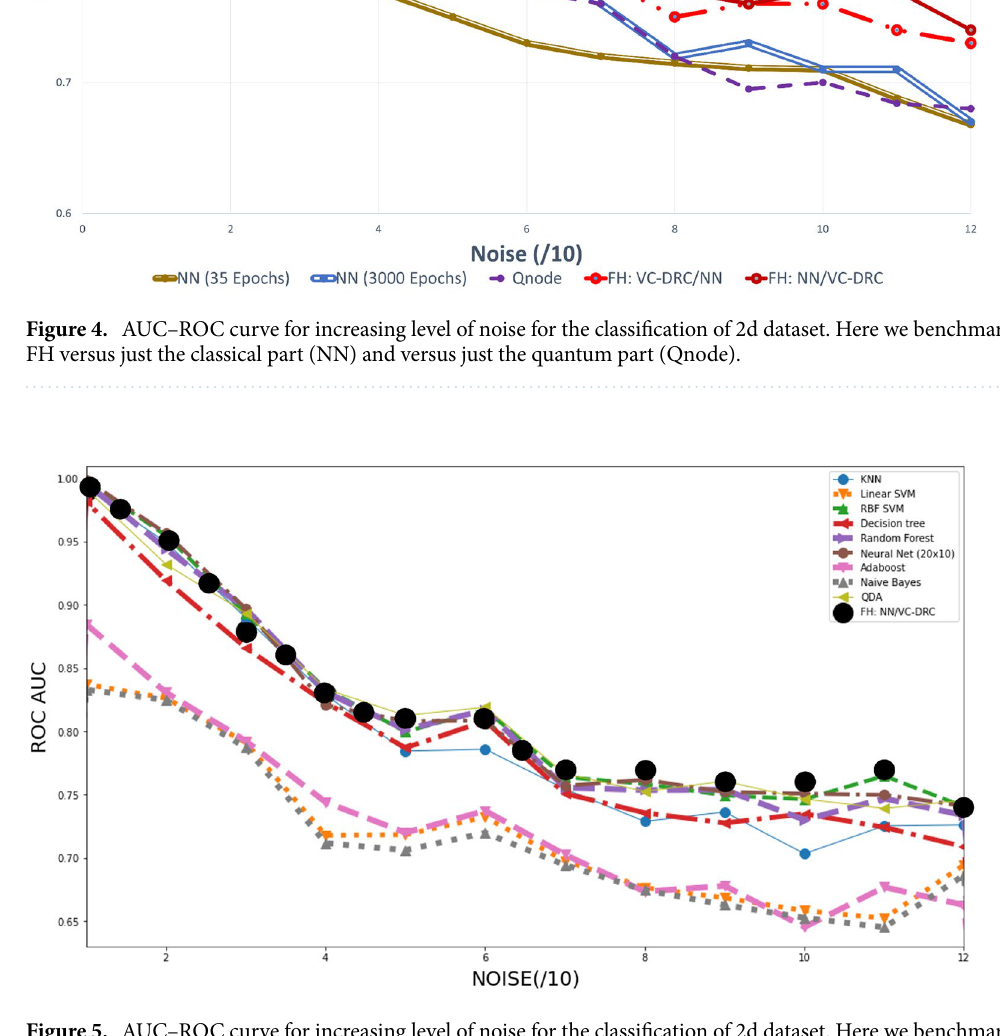
Figure 5. AUC–ROC curve for increasing level of noise for the classification of 2d dataset. Here we benchmark a great number of classical classifiers against our proposed FULL HYBRID